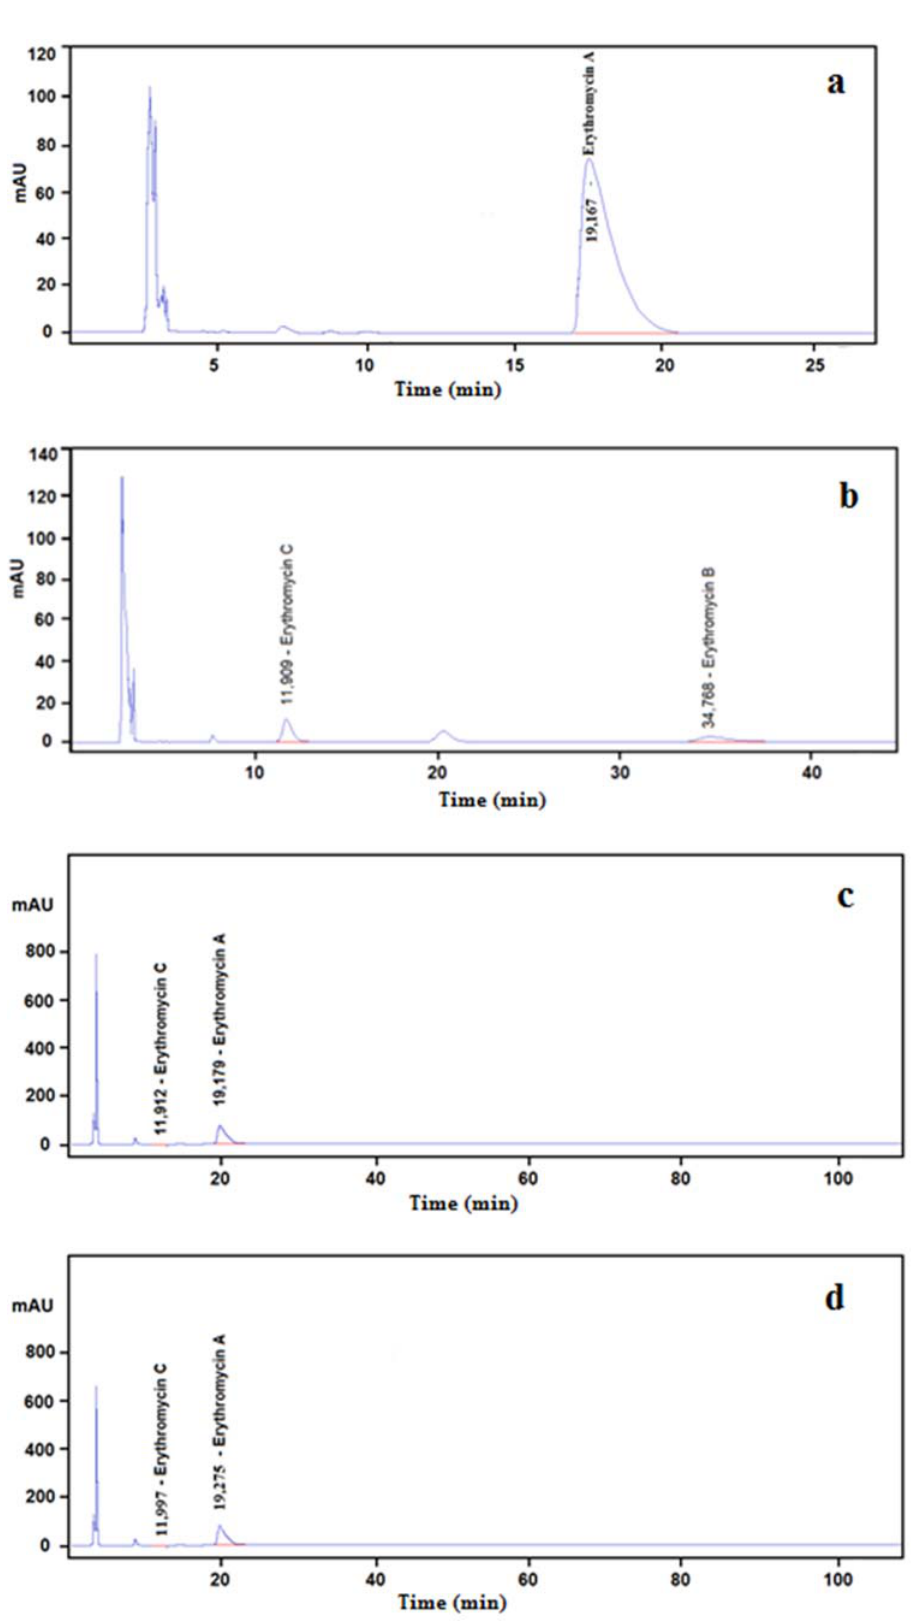
Figure 7. HPLC chromatogram for erythromycin references ( a , b ) and Ery ‐ PLA/PLGA samples ( c , d ). We observed (Figure 8) that drug release from Ery ‐ PLA was slowly more increased than from Ery ‐ PLGA nanostructures. In the case of Ery ‐ PLA, almost 55% of the antibiotic